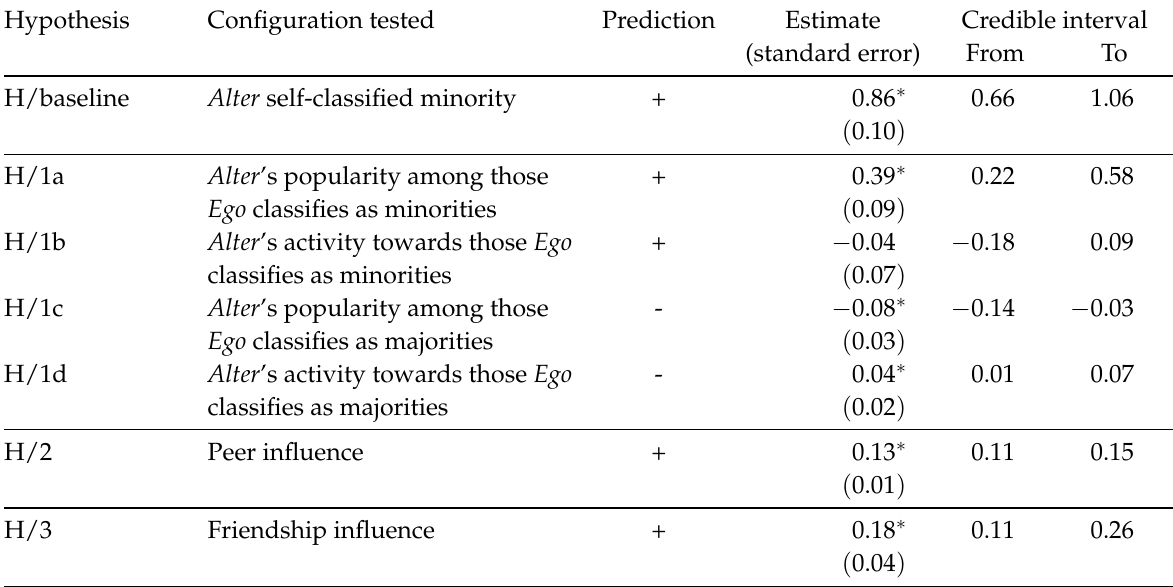
Table 2: SAOM results.